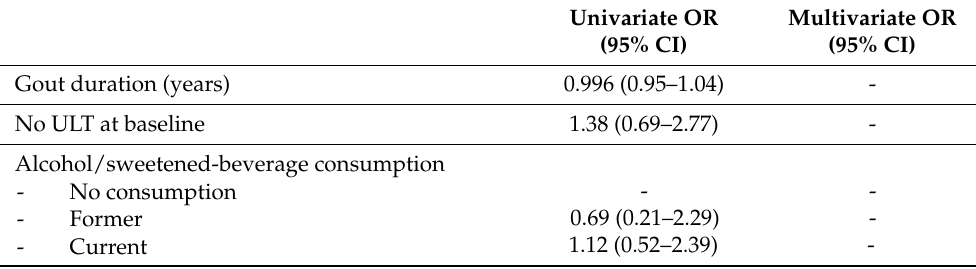
Table 2. Predictive factors associated with serum-urate levels < 6.0 mg/dL at a visit in a referral